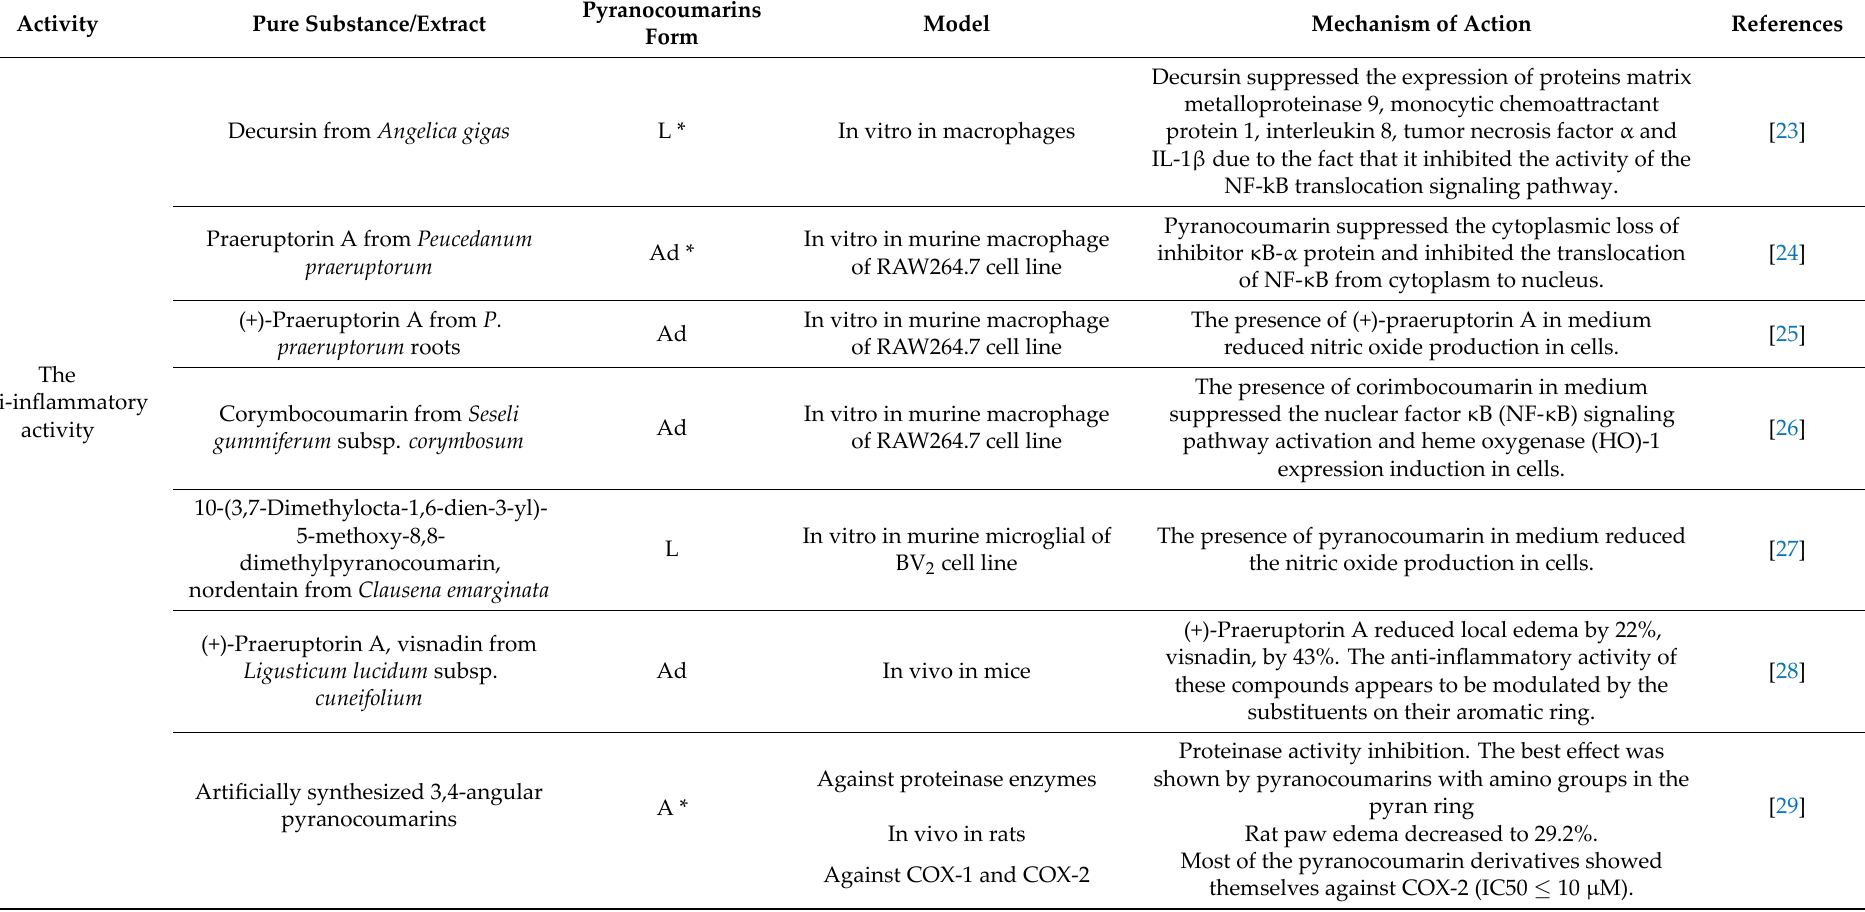
Table 1. Biological activities of